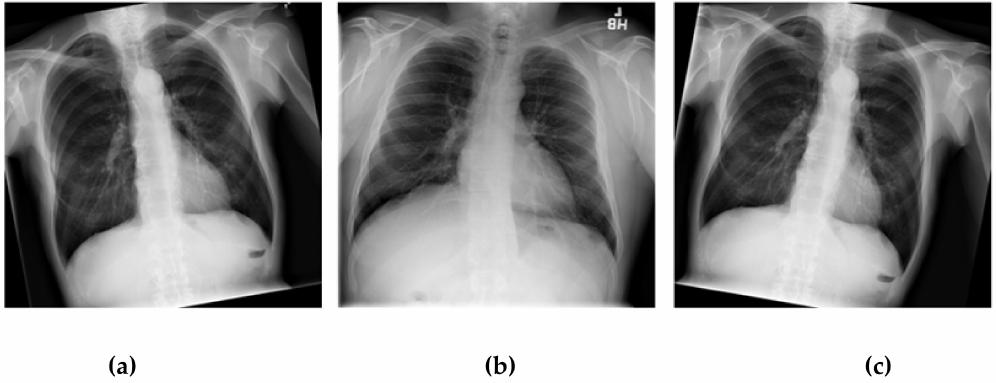
Figure 8. Examples of distorted chest X-ray images: ( a ) the patient’s normal spine tilted − 10 degree by rotating; ( b ) a patient’s abnormal spine; ( c ) a patient’s normal spine tilted 10 degree by